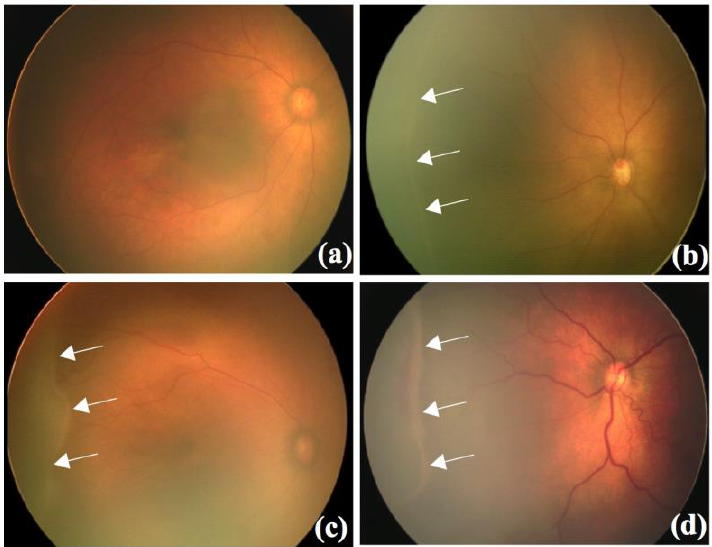
Figure 1. Illustration of retinal fundus images at different stages of retinopathy of prematurity (ROP; indicated by arrows). ( a ) Normal/NOROP; ( b ) ROP-Stage 1; ( c ) ROP-Stage 2; and ( d ) ROP-Stage 3.